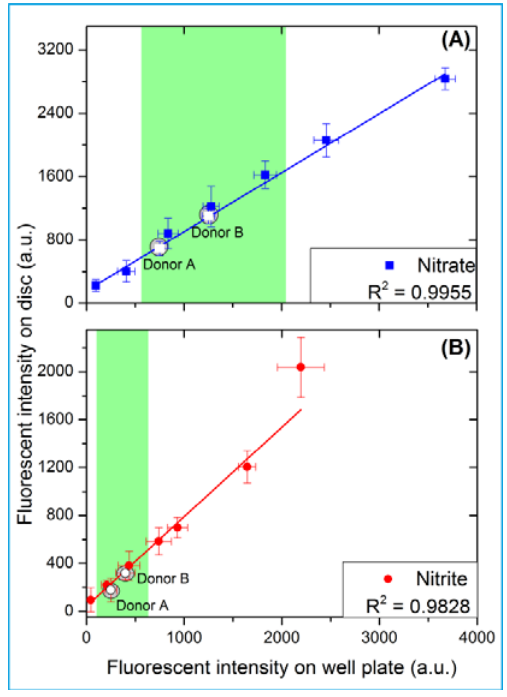
Figure 6. Calibration curves for ( A ) Nitrate and ( B ) Nitrite assays obtained from a standard 96-well plate and the automated disc platform showing the good correlation (R 2 = 0.9955 and R 2 = 0.9828, respectively) between both results. The highlighted region is the normal range of nitrate and nitrite levels for adults, and the results obtained using this assay from two anonymous blood donors (A & B) are also